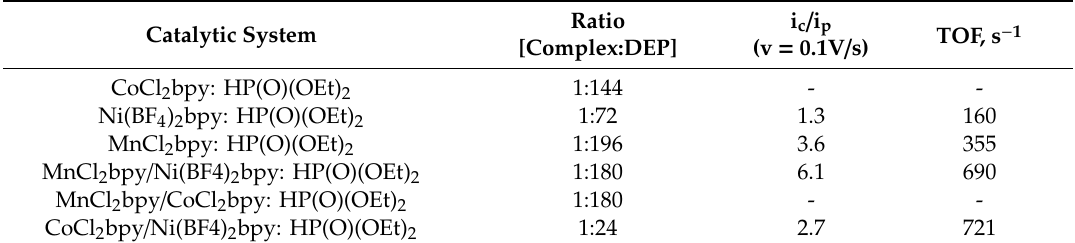
Table 1. Catalytic growth of the current at the first oxidation peak, and TOF of catalytic systems used in the phosphorylation reactions. [Mbpy] = 5 × 10 − 3 M (1.7 × 10 − 3 M for